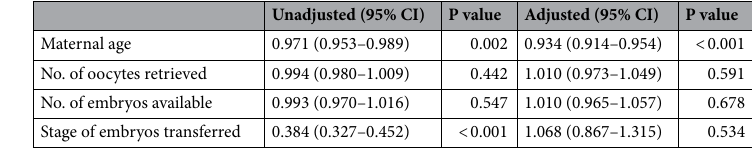
Table 3. Hazard ratio for pregnancy per time to pregnancy in patients with previous ectopic